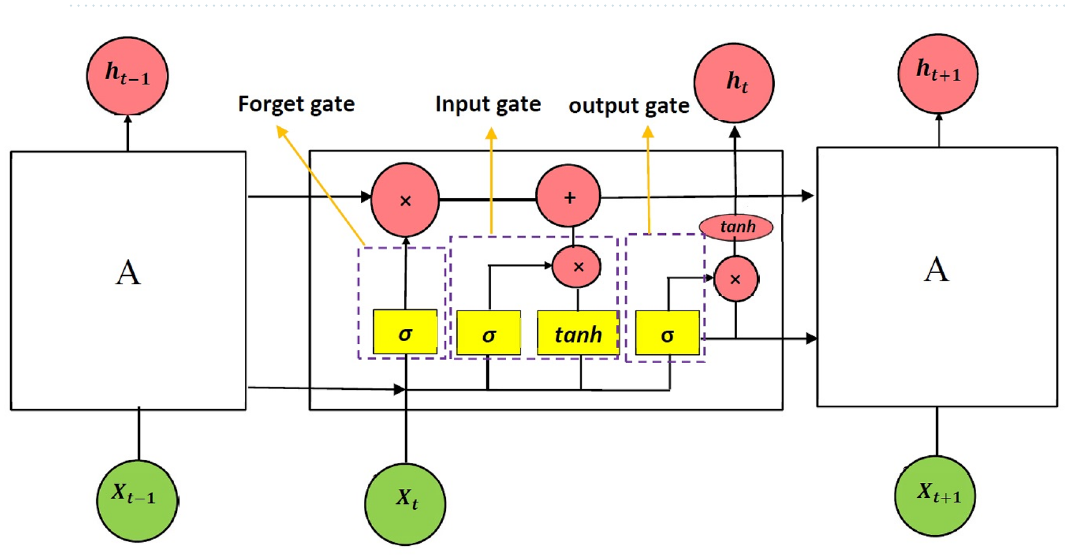
Figure 3. Structure of the Long Short Term Memory (LSTM), encompassing the three gates; forget, input and output. X denotes the input of the memory, h is the prediction at time t, and σ is a function that selects which information to retain or